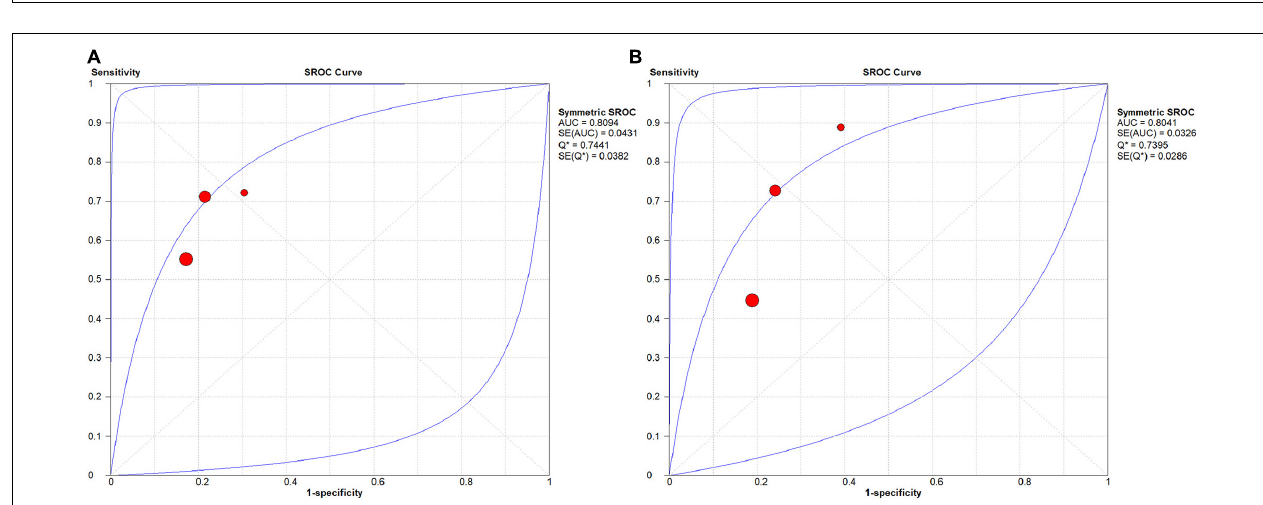
FIGURE 8 | Forest plots showing the pooled sensitivity and specificity in the task of pMCI vs. sMCI classification. (A) The pooled sensitivity in the GAN group and (B) the non-GAN group. (C) The pooled specificity in the GAN group and (D) the non-GAN group.